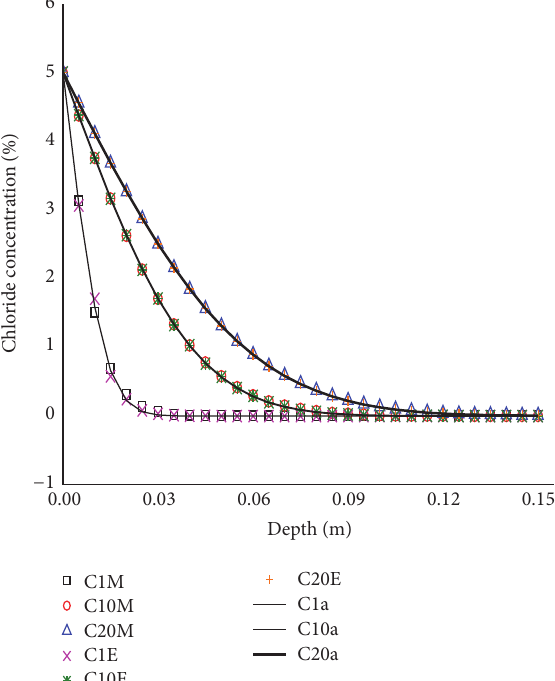
Figure 3: Variation of chloride concentration with depth.